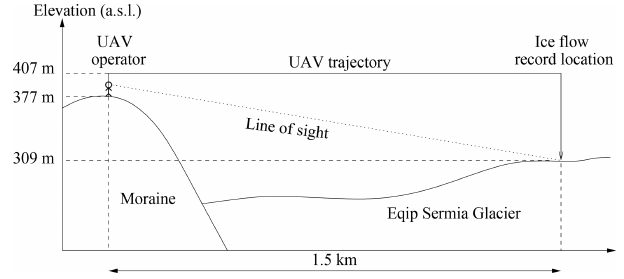
Figure 4. Trajectory of the UAV from the glacier margin to the se- lected site for in situ measurements of the ice